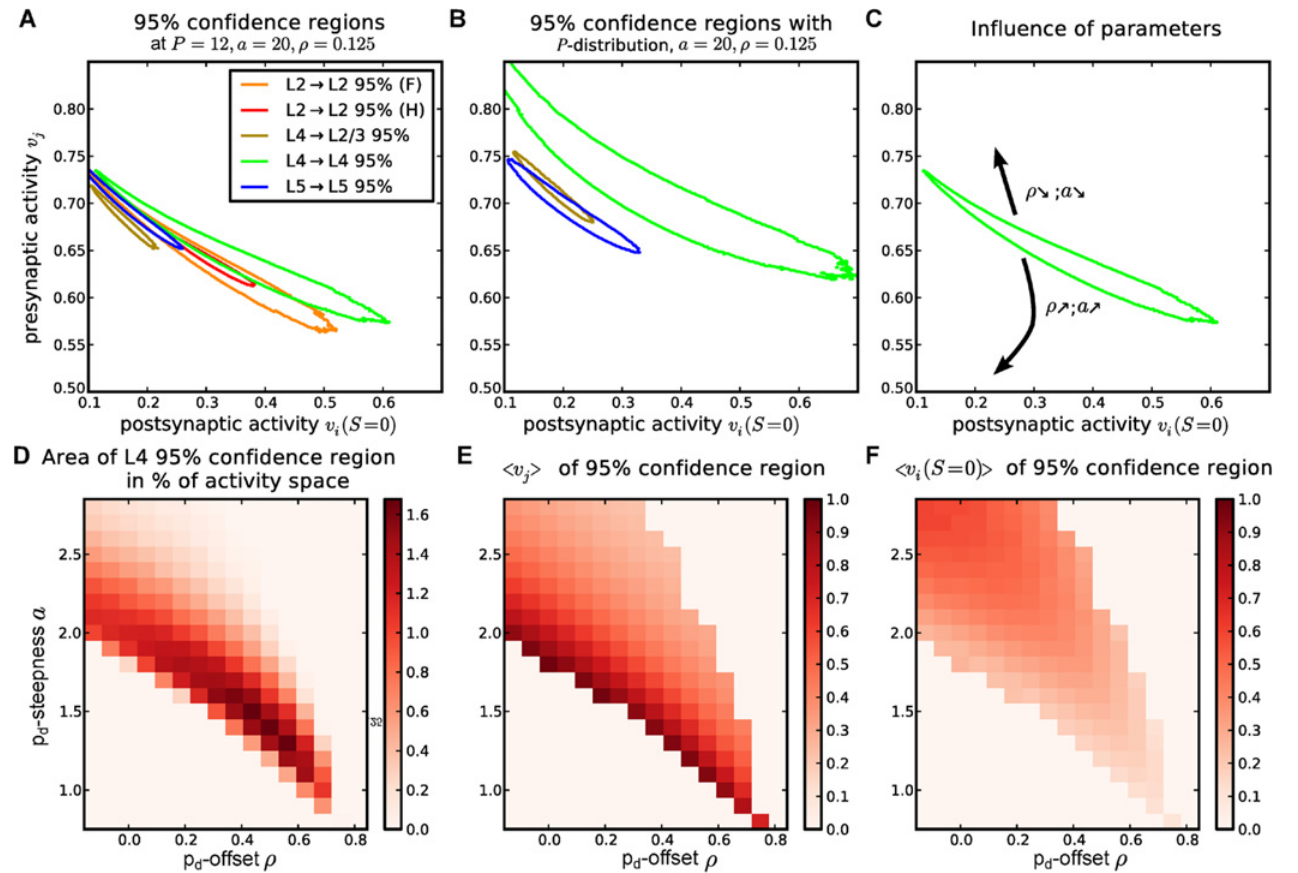
Figure 5. Different experimental data can be explained at different activity regions; effects are robust to underlying distributions or parameter changes. (A) The 95% confidence regions for experimental data from different cortical layers ([10, 36, 37], Fig. 1A) are located at different activities for different layers. Confidence regions for same experimental location (layer II) overlay. (B) The 95% confidence regions, which emerge from the same model parameters when using a distribution of potential synapses from [40], are qualitatively not different. (C) , Schematic drawing which summarises the influence of a and ρ on the location of the confidence region (see (E) and (F) ). For the layer IV data, we evaluated how (D) the area in activity space, (E) the average presynaptic activity, and (F) the average postsynaptic influence of the activity confidence region changes for different structural plasticity parameters a and ρ . (Parameters BCM rule with synaptic scaling with θ = 0.08, v tss = 0.1, κ = 9.0, structural plasticity: P = 12, ln p build = − 16, in A-C : a = 2.0, ρ = 0.125)